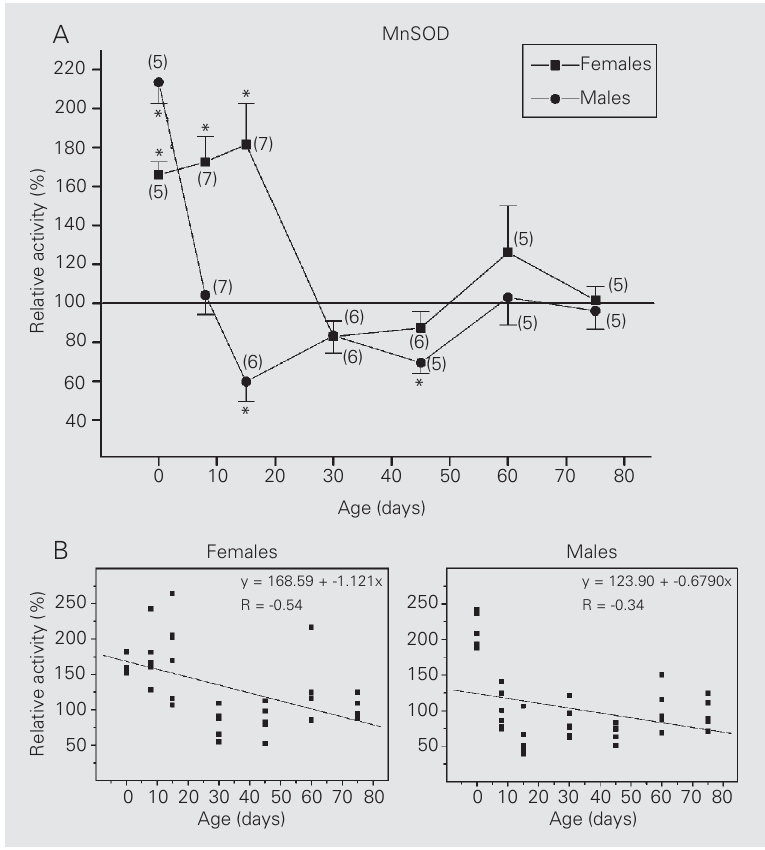
Figure 1. A , Effects of estradiol benzoate on manganese-superoxide dismutase (MnSOD) activity in female and male rats of different ages. Data are reported as means ± SEM as percent of olive oil control values for the number of rats given in parentheses (*P<0.05, t -test). B , Scatter-plot of MnSOD activity. P - significance of slope for females (P<0.001) and males (P<0.001),